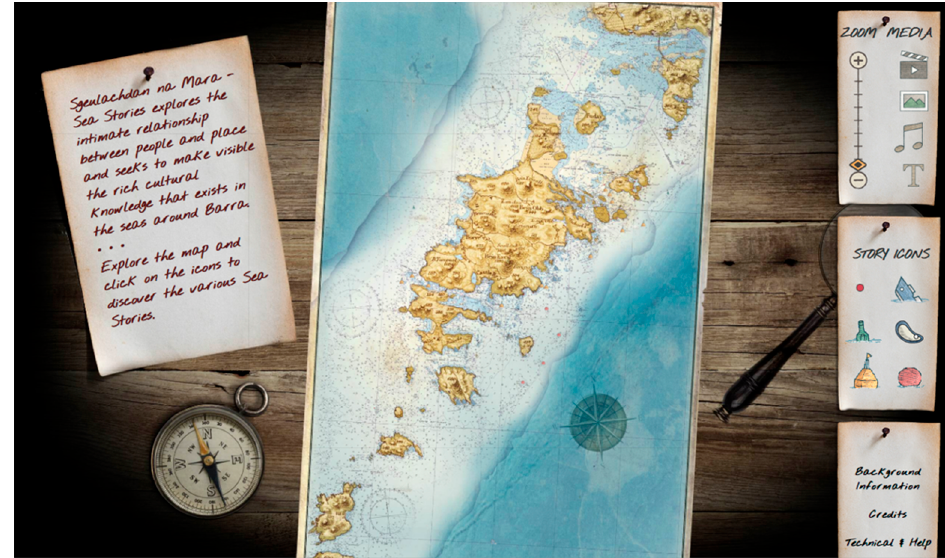
Figure 10. Screenshot of Bogha a Chlèirich. Sea Stories website. 23 Image used with permission form the artist.